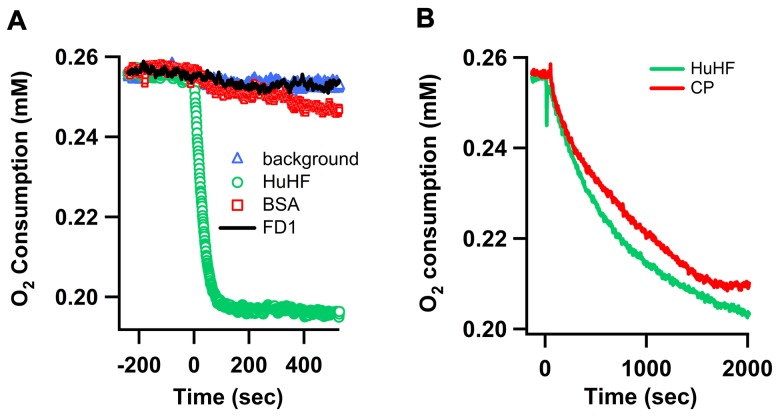
Oxygen consumption as a monitor of Fe(II) oxidation.